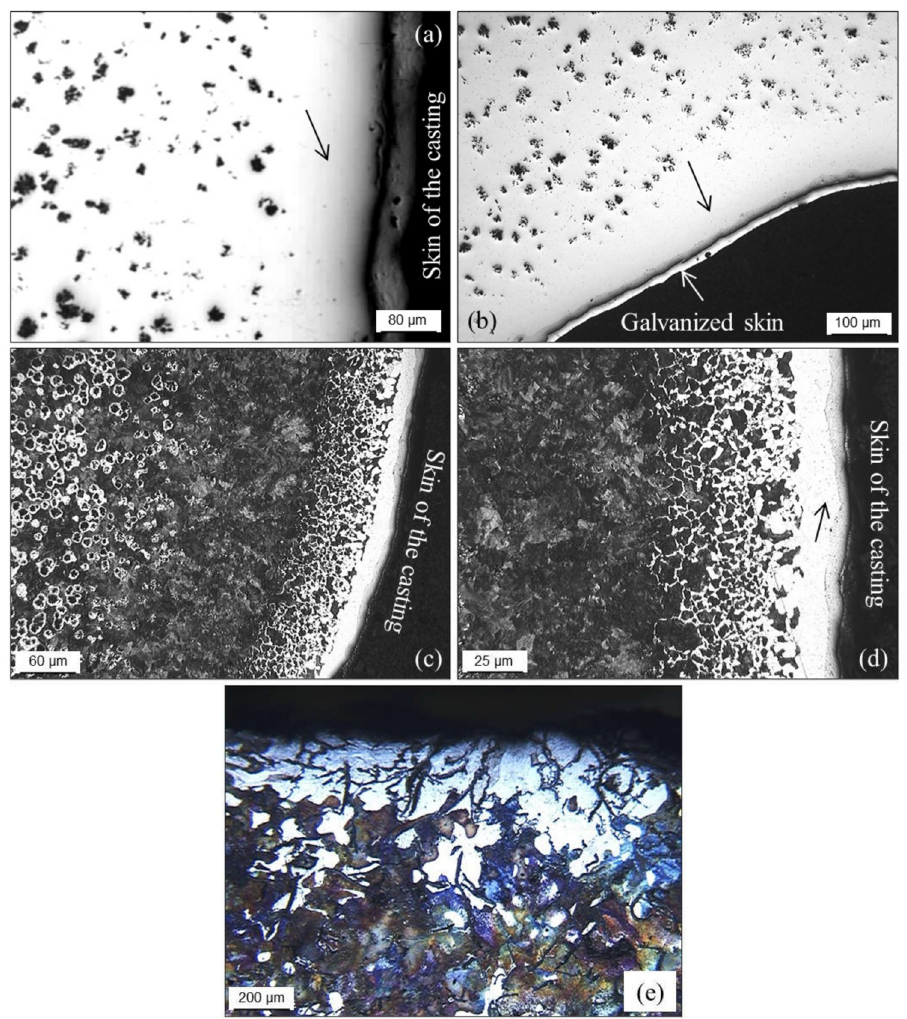
Figure 57. ( a , b ) examples of decarburized layers without graphite particles in malleable iron castings. ( c , d ) etched surfaces of a ductile iron casting produced in a die with a decarburized layer composed of three different zones: the inner segment is fully pearlitic, the intermediate one contains pearlite and ferrite and the outer one is fully ferritic. ( e ) Ferritic decarburization layer in a grey iron casting. The fully ferritic decarburized layer shown in Figure 57e in the case of a grey